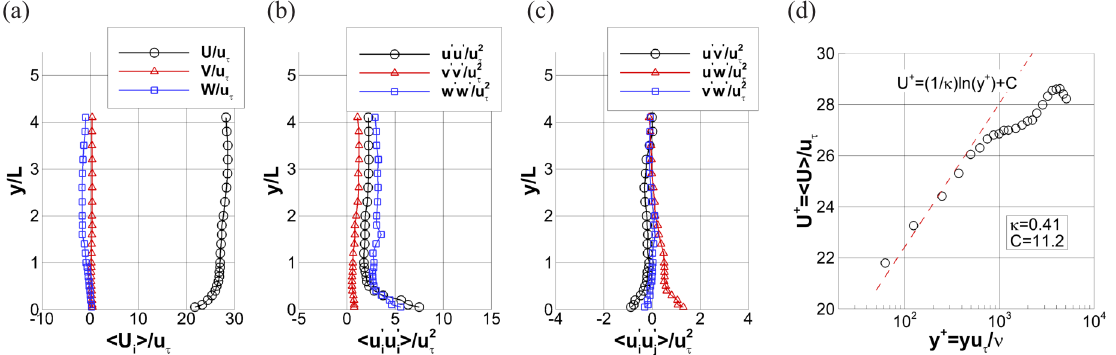
Figure 4. Incoming flow statistics along the spanwise direction at x / L = − 15: ( a ) mean velocity, ( b ) Reynolds normal stresses, ( c ) Reynolds shear stresses, and ( d ) log-law parametrization of the lateral boundary